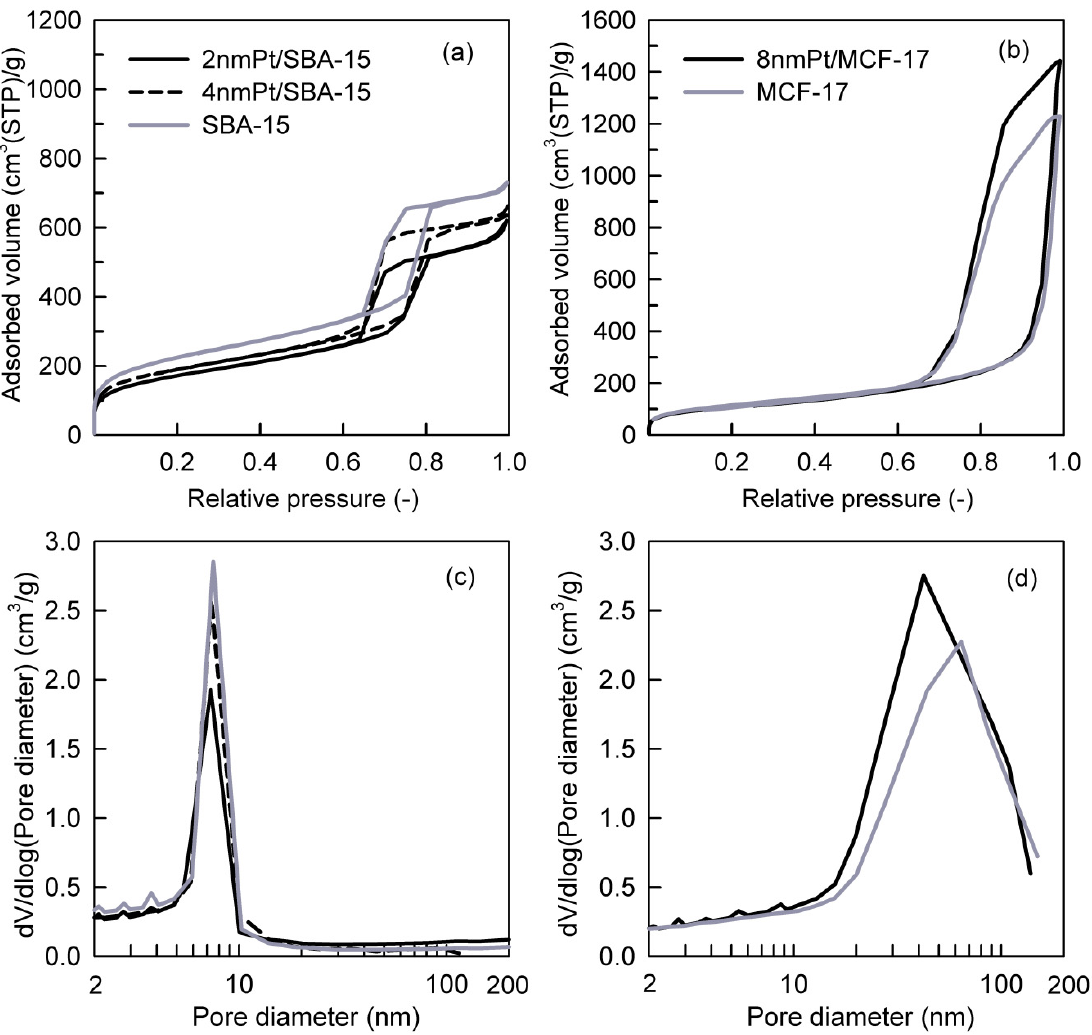
Figure 3. Nitrogen adsorption–desorption isotherms of ( a ) SBA-15-based and ( b ) MCF-17-based catalysts and evaluated pore-size distributions of ( c ) SBA-15-based and ( d ) MCF-17-based catalysts. Table 1. Textural properties and Pt loadings of SBA-15 and MCF-17 supported catalysts.